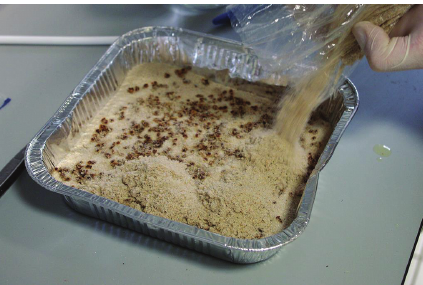
Figure 2: Addition of silica sand over gentian seeds for stratification